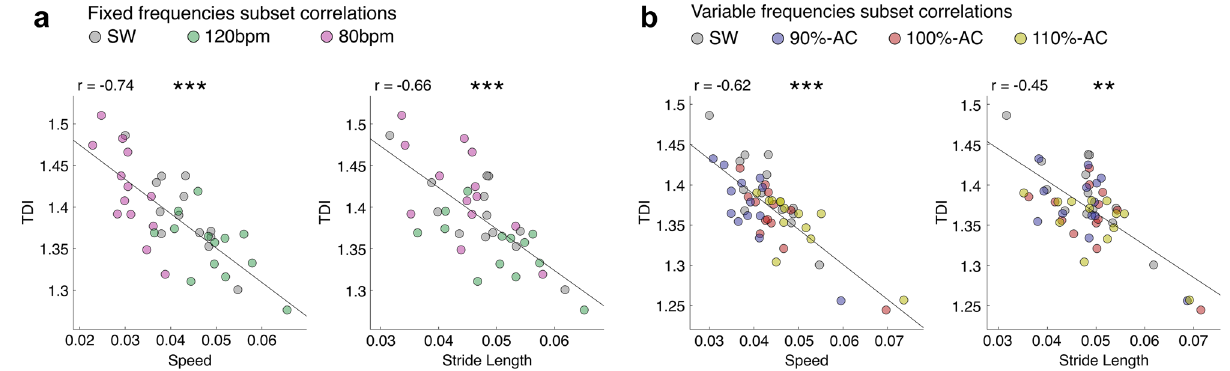
Figure 4. TDI and spatiotemporal gait parameters. Spearman correlation coefficient between trunk displacement index (TDI) and spatiotemporal gait parameters in simple walking (SW) vs. fixed and variable RAS frequencies separately. Average cadence (AC), beat per minute (bpm). Significance p value: *p < 0.05, **p < 0.01, ***p <